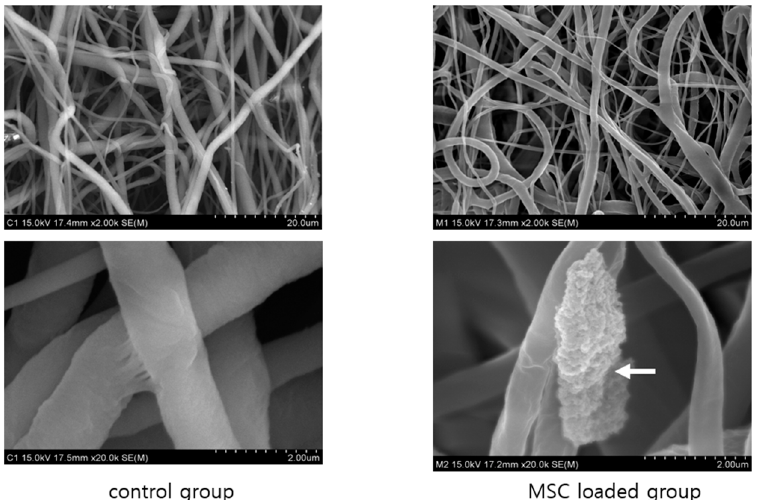
Figure 3. Scanning electron microscopic view of control group and MSC loaded group. Both groups show cellulose/collagen nanofibrous structure (2.0K). The magnified view shows well coated MSCs to the nanofibrous strand (arrow indicates).